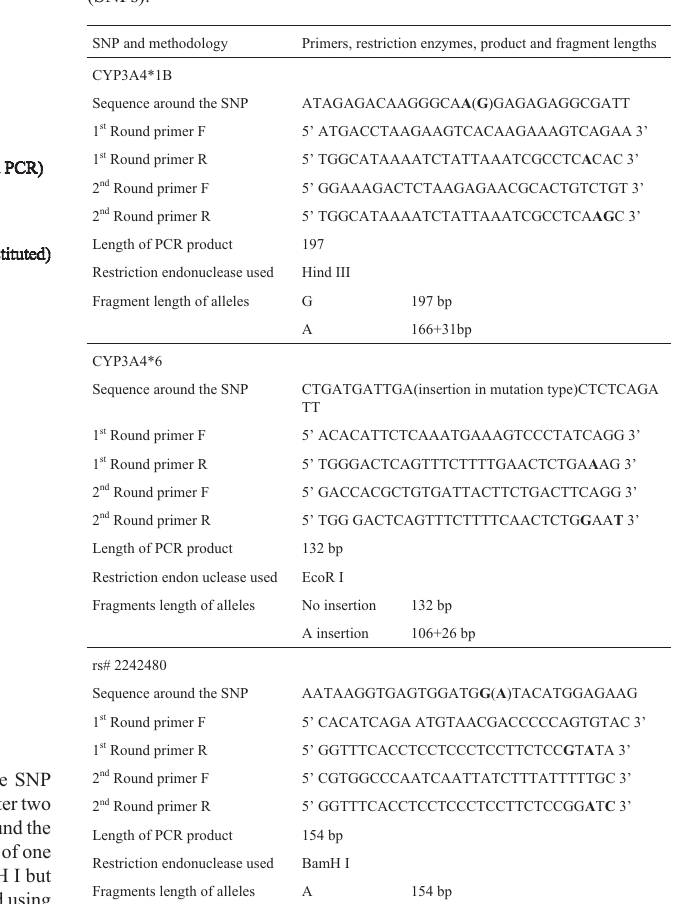
Table 1 - Primer Design of the three single nucleotide polymorphisms (SNPs).